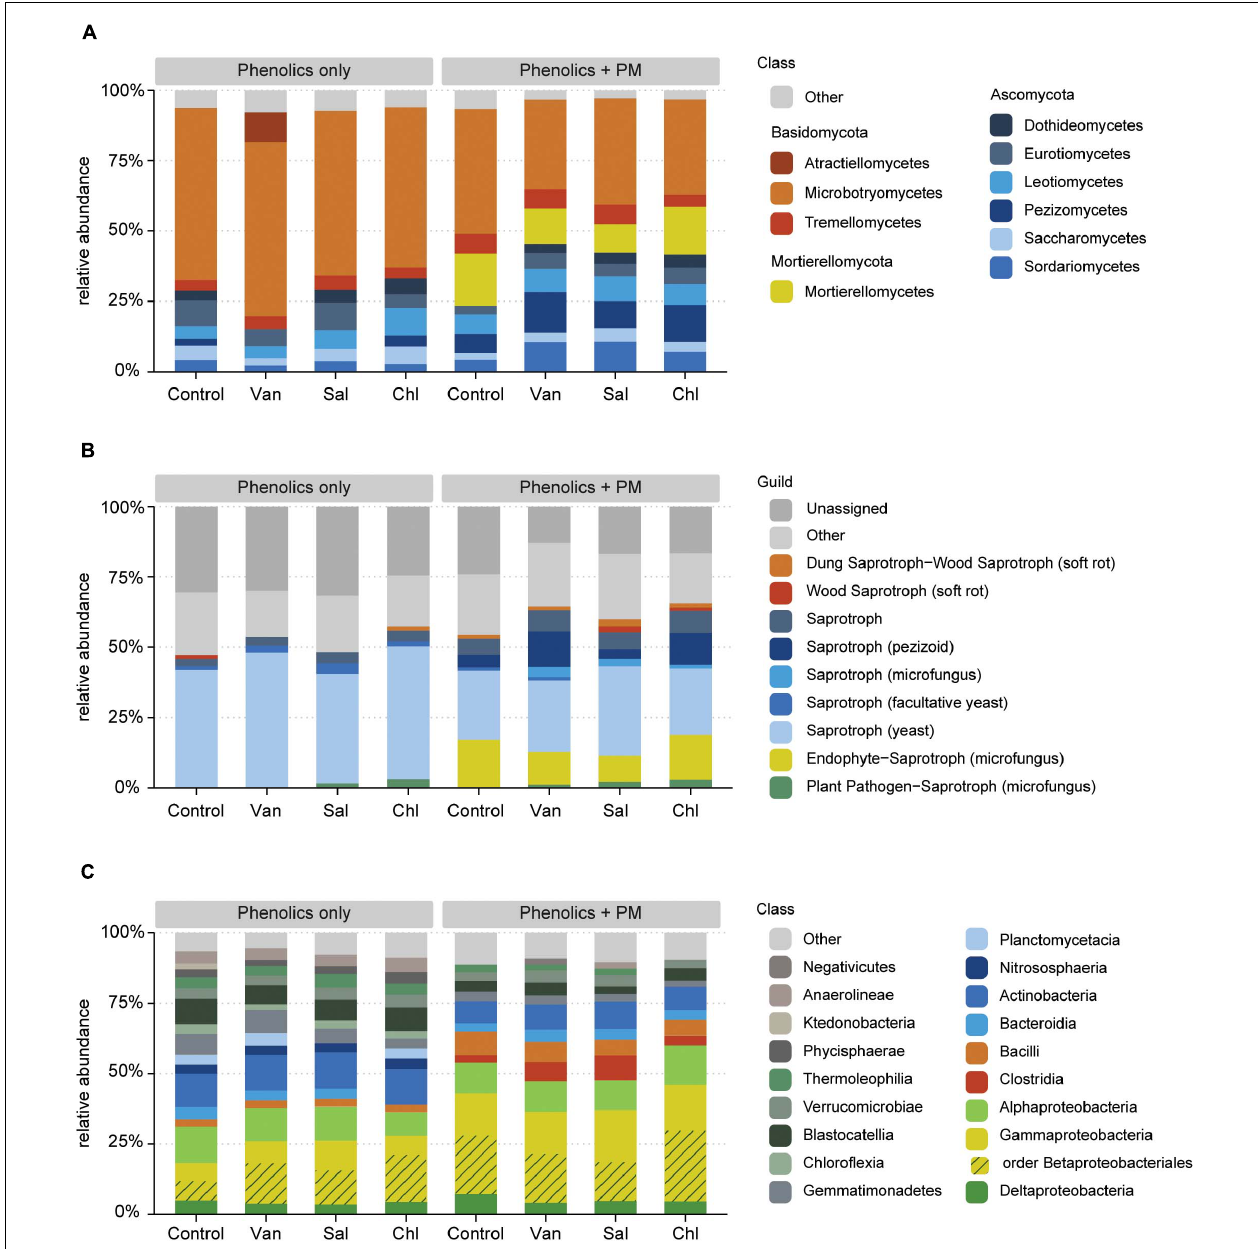
FIGURE 6 | Effect of phenolic acids (phenolics only) and phenolic acids combined with primary metabolites (phenolics + PM) on the relative abundance of fungal classes (A) , fungal functional groups (B) , and bacterial classes (C) , as detected in the arable soil compartment of rhizosphere simulation microcosms. Classes constituting < 2% of each community are displayed as “Other.” The result is shown for the control, vanillic acid (Van), salicylic acid (Sal) and chlorogenic acid